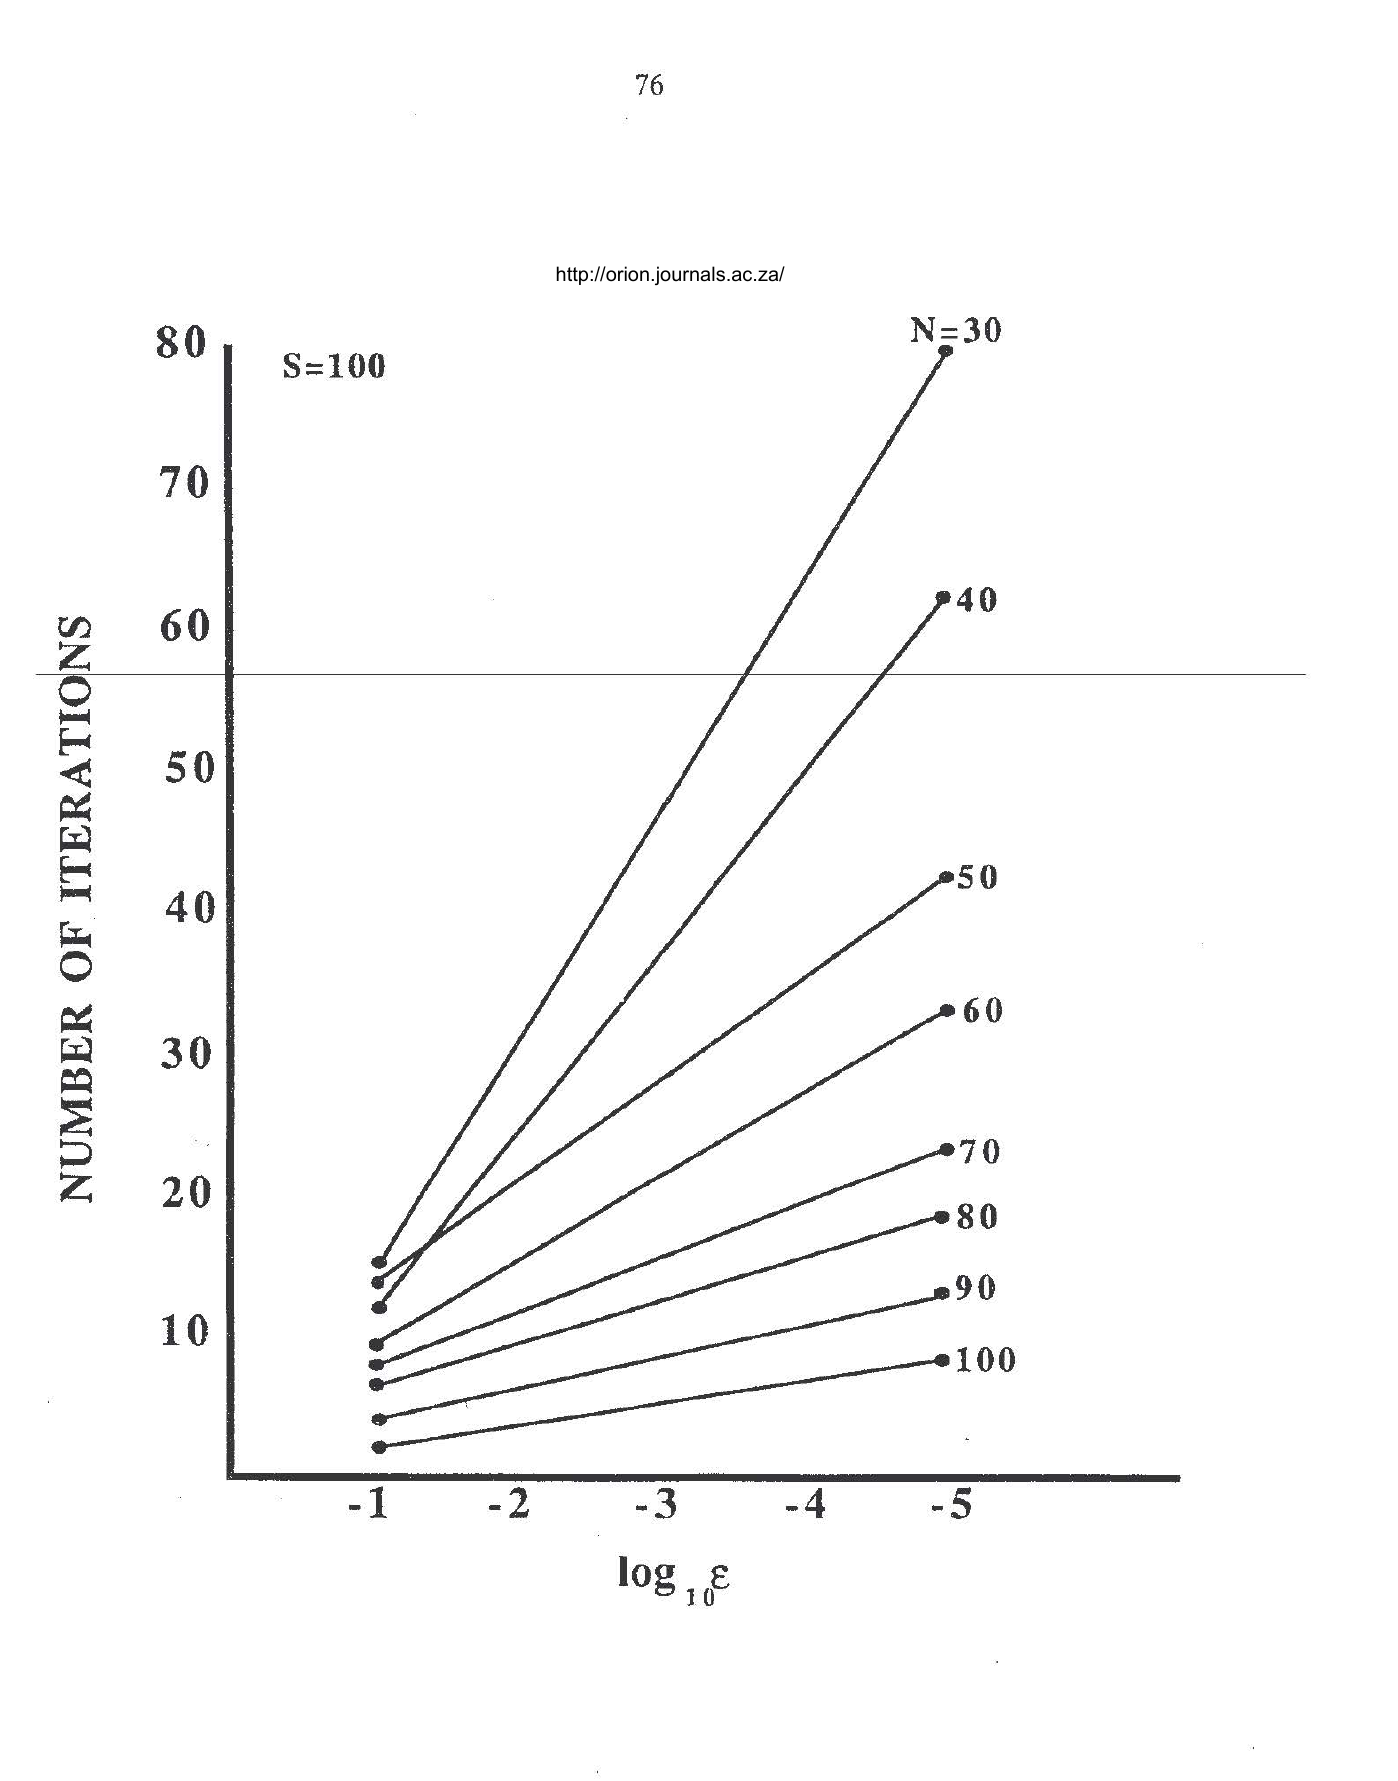
Fig. 3: The dependence of the number of iterations on log e and on N, for a fixed number of constraints (S =